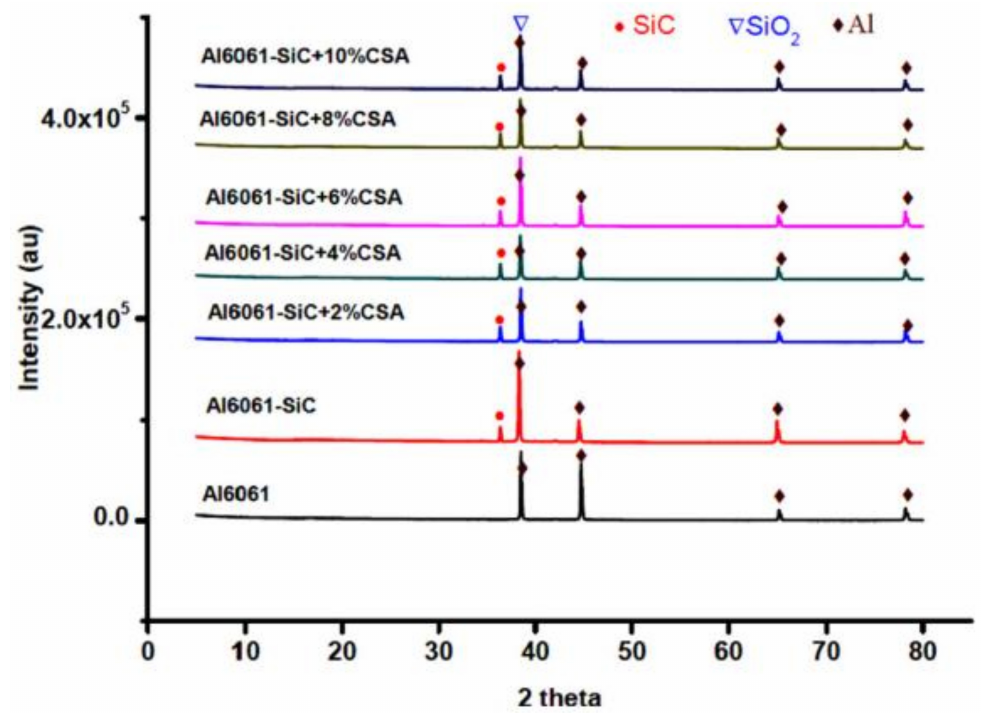
Figure 10. XRD peaks of Al6061 and its composites